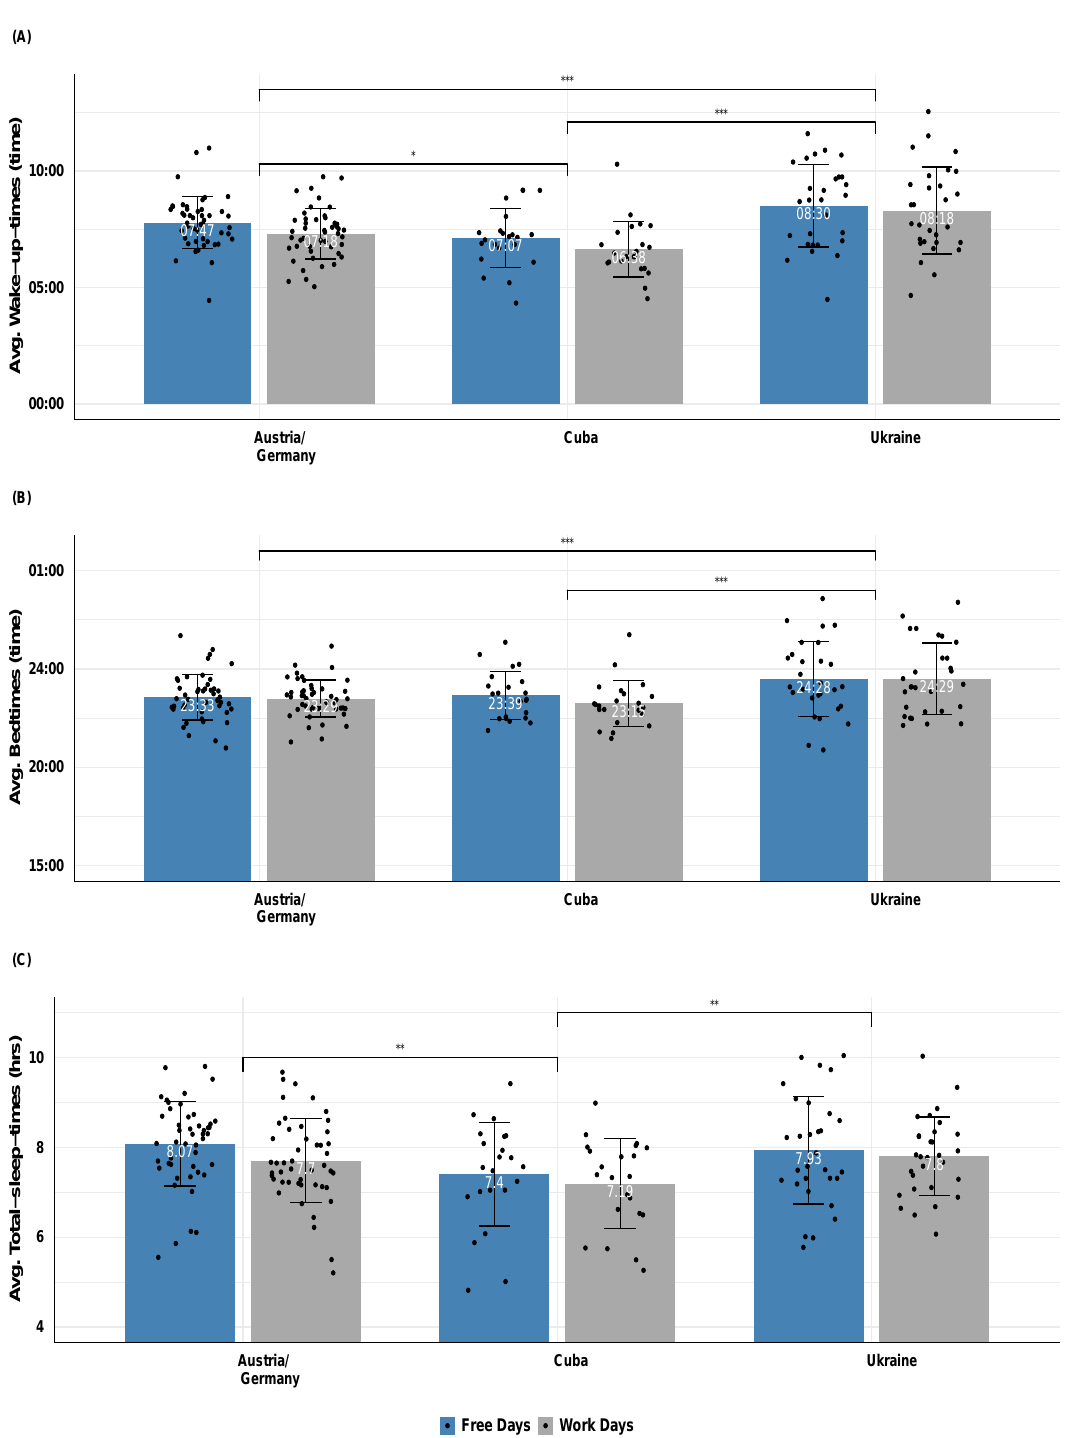
Figure 4. Objective sleep measures across countries. Average wake-up-times ( A ), bedtimes ( B ), and total-sleep-times ( C ) for each country (Austria and Germany, Cuba, and Ukraine) and day (work or free), as extracted by MB. Note that Ukraine had later wake-up and bedtimes than both Austria and Cuba. Austria had later wake-up-times and higher total-sleep-times than Cuba. Error bars indicate the standard deviation of the mean. Bonferroni-corrected pairwise marginal mean comparisons indicate significance at <0.1 +, <0.05 *, <0.01 **, <0.001 ***, and non-significant (NS)